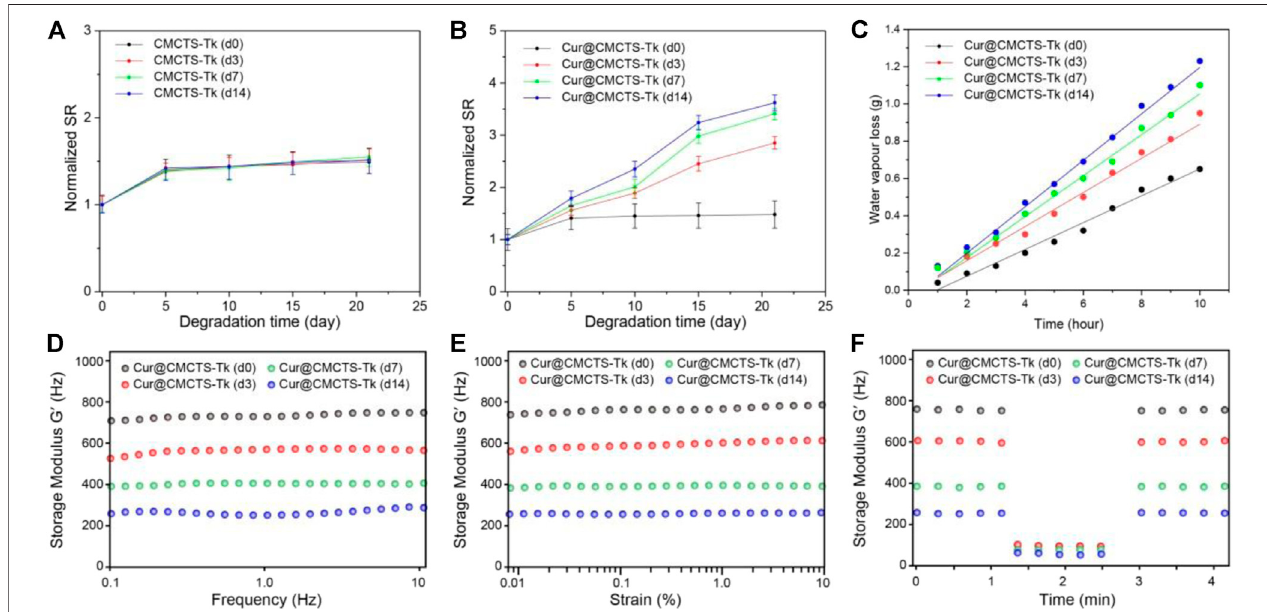
FIGURE 3 | Normalized swelling ratio of CMCTS-Tk (A) and Cur@CMCTS-Tk (B) hydrogels treated with H 2 O 2 for 0, 3, 7, and 14 days. (C) Water vapor loss of Cur@CMCTS-TkhydrogeltreatedwithH 2 O 2 for0,3,7,and14 days. (D) Frequency-dependent(from0.1to10 Hz), (E) strainsweeping(atamaximumstrain10%),and (F) oscillatory mode with a frequency (1.0 and 100 Hz) of storage modulus (G ′